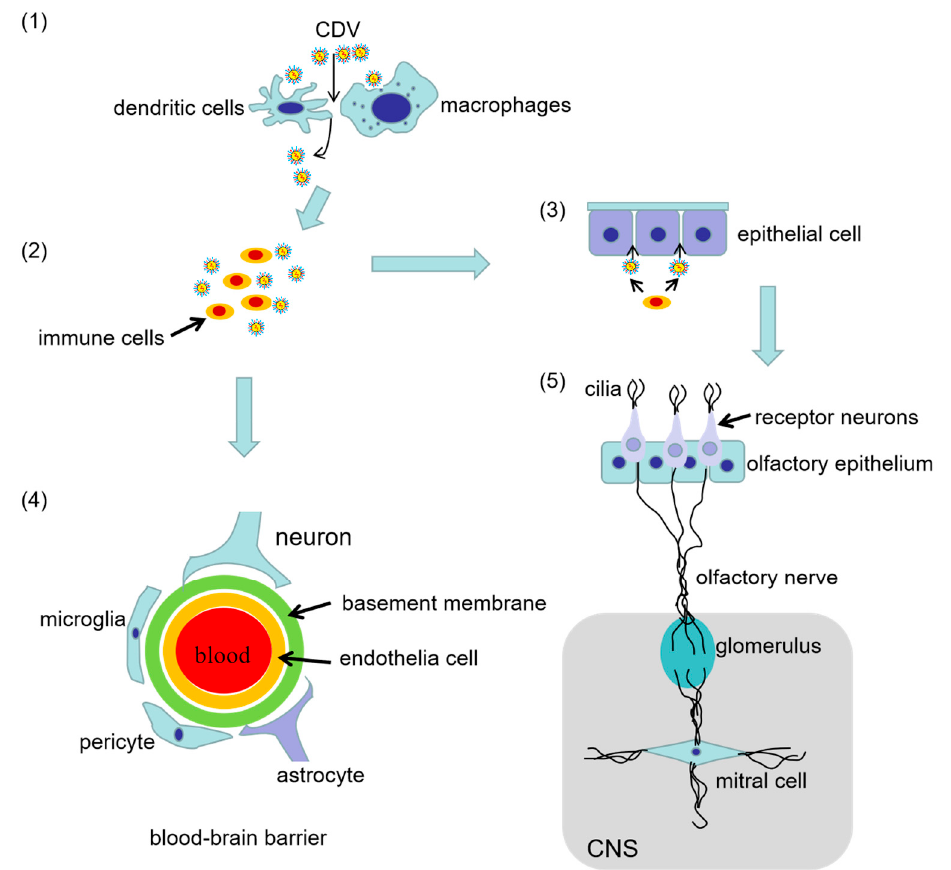
Figure 2. Diagram illustrating two CDV entry pathways into the CNS. Initially, CDV invades and spreads in airway immune cells (macrophages or dendritic cells) by binding to SLAM ( 1 ). CDV infects immune cells in the lymph nodes by binding to SLAM and leads to primary viremia and immunosuppression ( 2 ). Later, the virus spreads to epithelial cells expressing nectin-4 via infected immune cells ( 3 ). In the proposed hematogenous dissemination pathway, CDV induces endothelial damage, leading to a compromised BBB and the penetration of brain vessels by leukocytes. Then, the virus exits the periphery and infects the central nervous system (CNS) by infiltrating the BBB. The BBB is composed of brain microvascular endothelium cells with specialized tight junctions surrounding the basement membrane, pericytes, astrocytes, and neurons ( 4 ). The anterograde pathway through the olfactory nerve involves invasion via the olfactory epithelium and olfactory neurons.